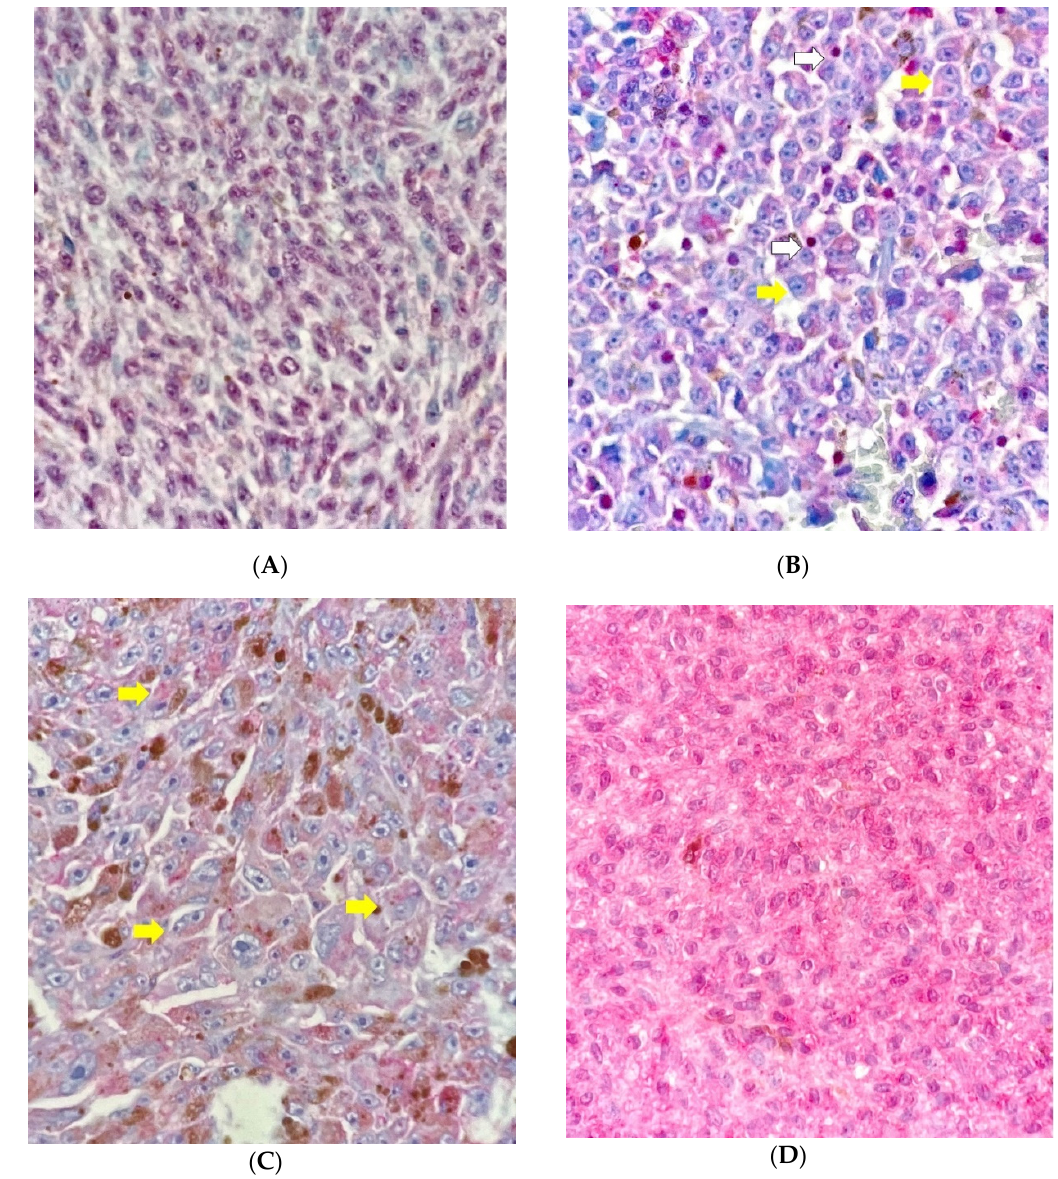
Figure 3. Cytoplasmic BAP1 staining. ( A ) Grade 0 = positive staining in less than 10% of cells per high-power field (×400). ( B ) Grade 1 = positive staining between 10% and 33% of cells per high-power field (×400). Positive cytoplasmic stain (yellow arrows) and lymphocytes used as positive control (white arrow). ( C ) Grade 2 = positive staining between 34% and 66% of cells per high-power field (×400). Positive cytoplasmic stain (yellow arrows). ( D ) Grade 3 = positive staining in ≥ 66% of cells per high-power field (×400).